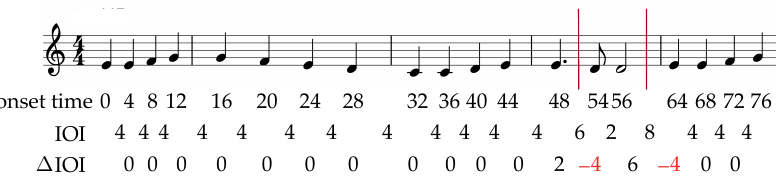
Figure 5. An example of phrase identification by applying GPR in GTTM. The onset time is based on our duration vocabulary introduced in Section 2.1.